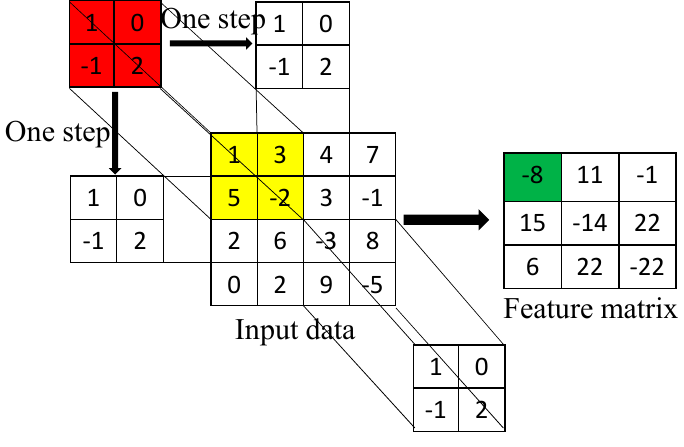
Figure A1. Convolution process.